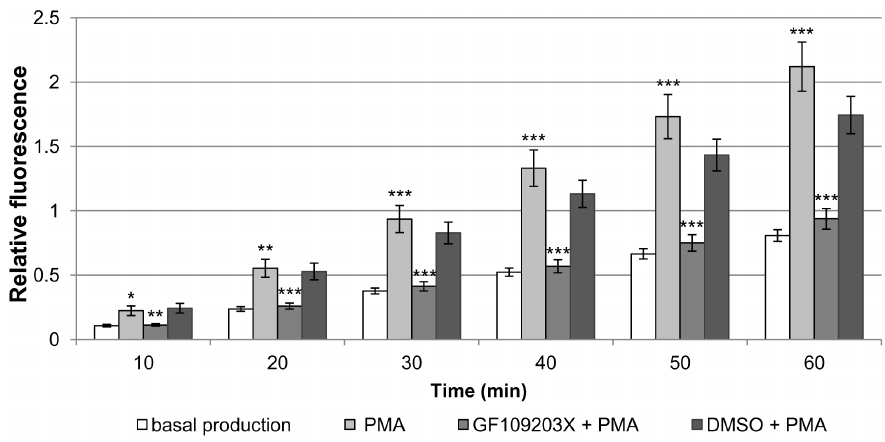
Figure 9. PMA-stimulated H 2 O 2 production in haemocytes from uninfected Radixlagotis , and the effect of PKC inhibition on H 2 O 2 production. H 2 O 2 output by haemocyte monolayers in the presence of PMA (5 m M), GF109203X (5 m M) and PMA, DMSO (vehicle) and PMA, or SSS + alone was detected by Amplex red and the intensity of fluorescence was measured by microplate reader over 60 min. The mean ( 6 SEM; n=7) relative fluorescence values shown represent the increase in H 2 O 2 production over time in the various treatments. *p , 0.05, **p , 0.01, ***p , 0.001, for PMA values compared to basal production, and **p , 0.01, ***p , 0.001 for GF109203X + PMA compared to DMSO + PMA; paired t-test or paired- samples Wilcoxon test combined with Fishers’s combination test.